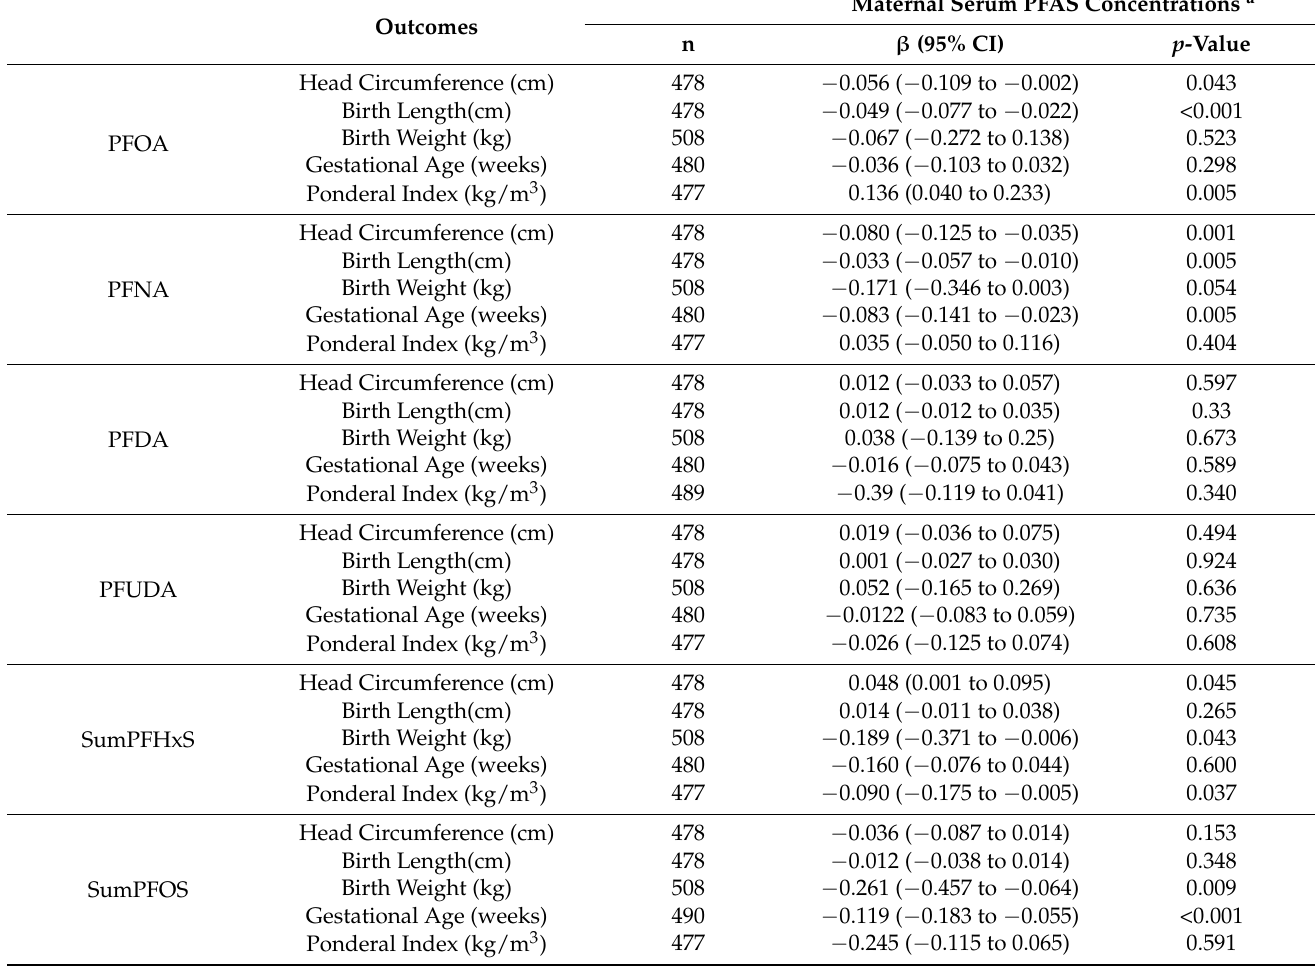
Table 4. Multivariable analysis results of linear regression analysis measuring effects of maternal serum PFAS concentrations on birth